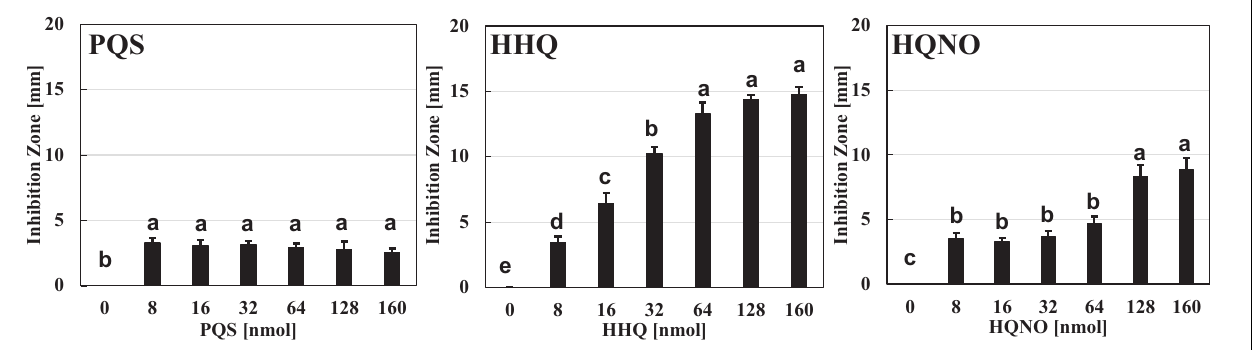
FIGURE 3 | Effect of each quinolone compound itself on the predation plate assays using a mixture of Bdellovibrio bacteriovorus 109J and Escherichia coli BW25113. The inhibition zone for the predation plate assay using a mixture of B. bacteriovorus 109J and E. coli BW25113 was compared in the presence of PQS, HHQ, or HQNO compound (0, 8, 16, 32, 64, 128, or 160 nmol) placed on the plate after incubation at 30 ◦ C for 4 days. The 0-nmol sample is the control with DMSO alone. PQS, Pseudomonas quinolone signal, 2-heptyl-3-hydroxy-4(1H)-quinolone; HHQ, 2-heptyl-4-quinolone; HQNO, 2-heptyl-4-quinolinol 1-oxide. n = 3. The value among each sample with different letters is significantly different ( p < 0.05).